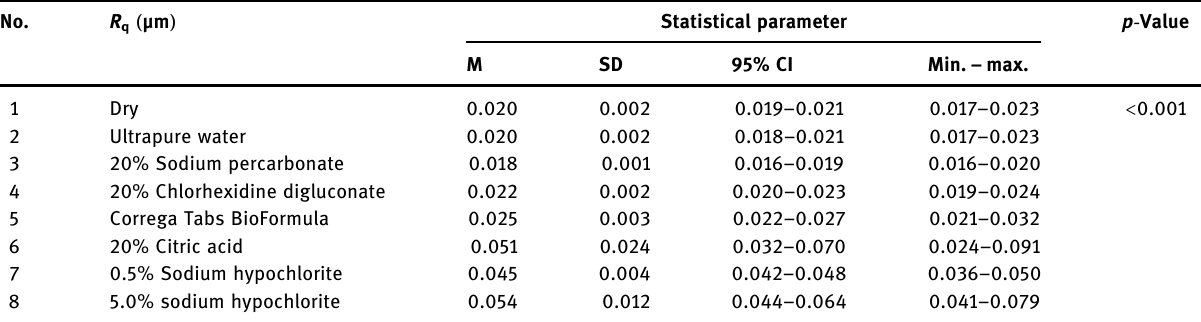
Table 3: Descriptive statistics for R q measurements outcome